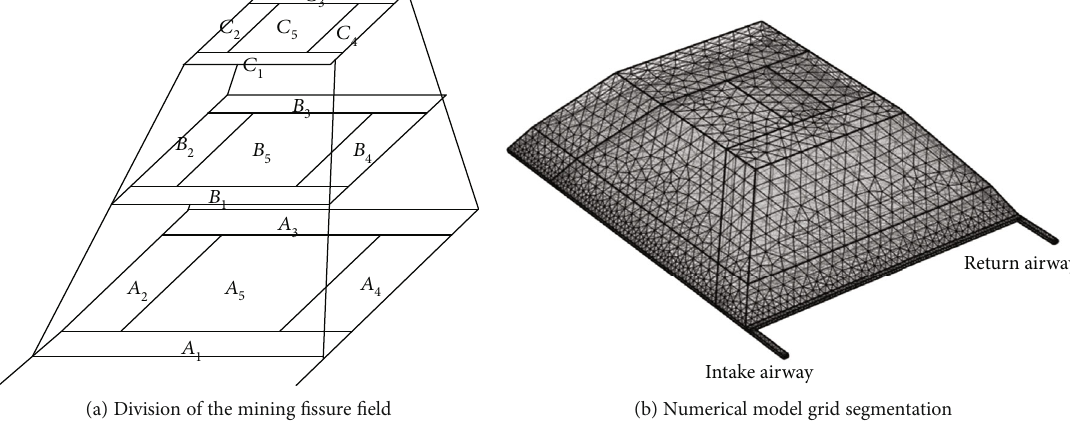
Figure 7: Numerical model of gas migration in goaf. Table 2: Coe ffi cient of dilatation of rock collapse of each